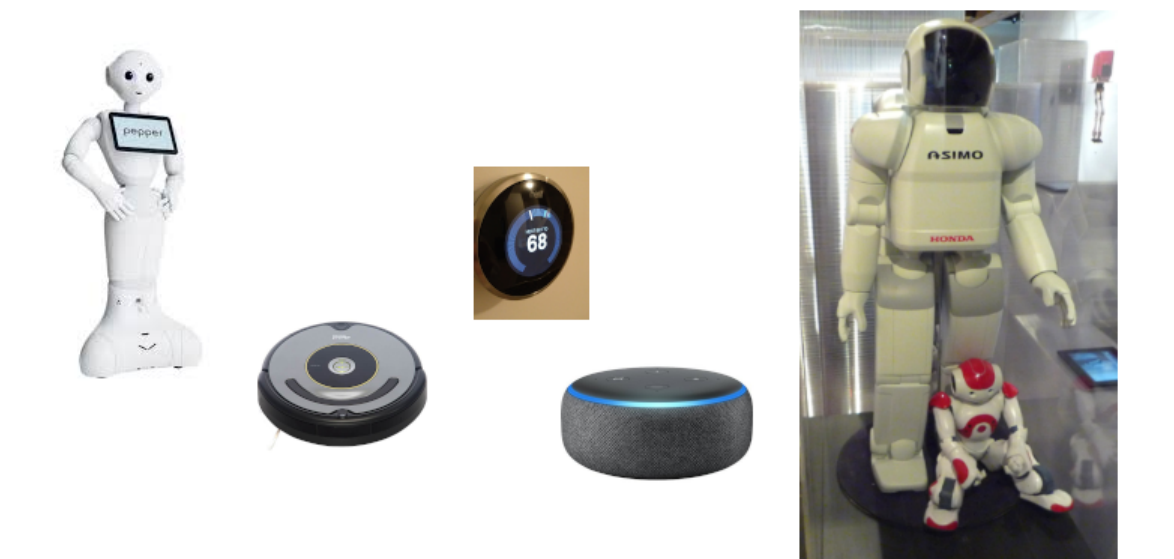
Figure 1. Samples of domestic robots: (from left) Pepper, iRobot Roomba, Nest Thermostat, Amazon Alexa, an NAO in front of